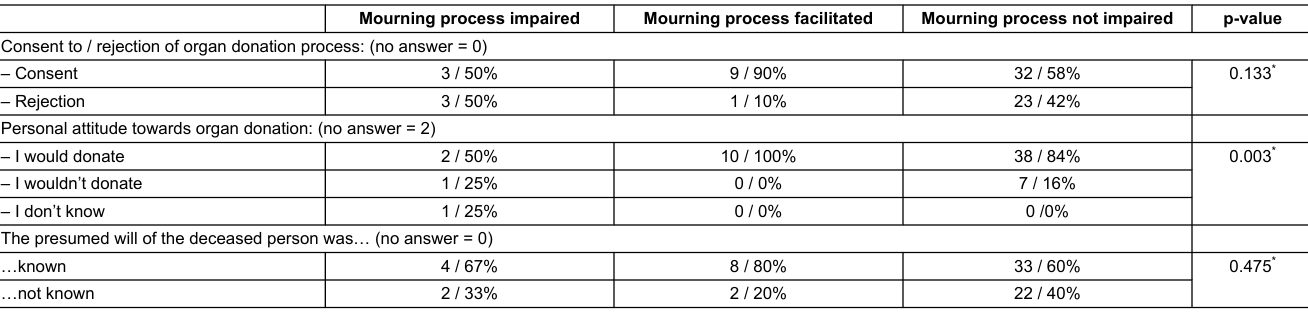
Table 4: Language, personal attitude, knowledge of presumed will of the next of kin, and correspondence of the final decision with the presumed will.